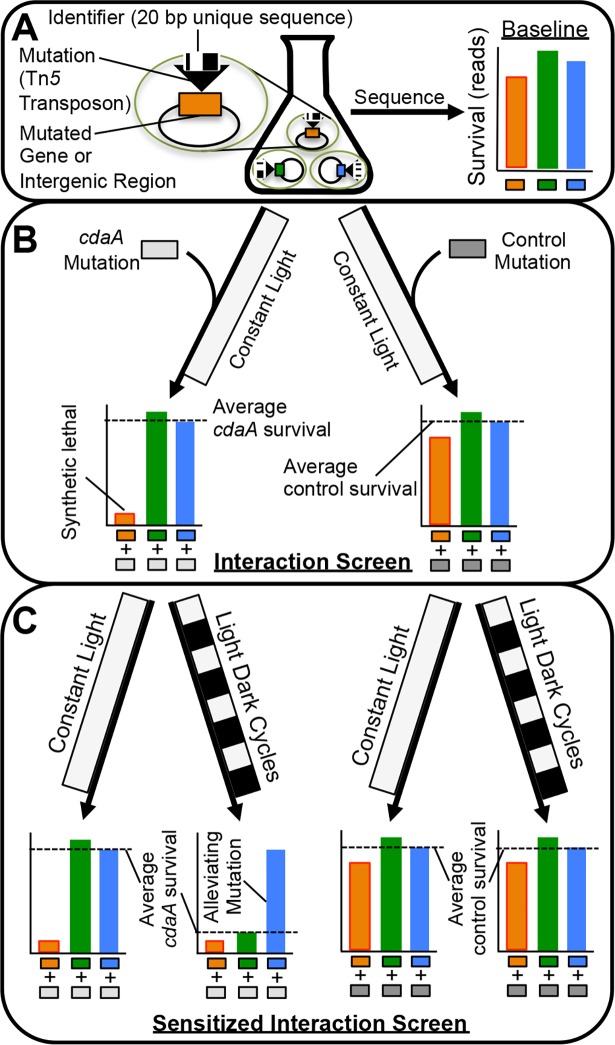
IRB-Seq approach to genetic interaction screens.(A) Each mutant in the starting library contains a loss-of-function mutation with a unique identifier sequence (barcode) that has been previously linked to the mutation’s locus. After the archived library is thawed the barcodes present in each mutant are sequenced using next-generation sequencing to determine their baseline levels. (B) The library is then split into two aliquots with one receiving an experimental mutation (AM5403 for this screen), and one receiving a control mutation with no expected fitness costs (AM5329 for this screen). After outgrowth, these two aliquots are sequenced for barcode quantification and compared, which allows identification of genetic interactions between the experimental mutation and the preexisting barcoded mutations. (C) The double mutant library is grown under a condition of stress for the experimental mutation and a four-way comparison between it and controls for genotype and stress condition enables identification of genetic interactions.